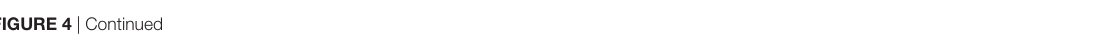
FigUre 4 | Continued Specific CD8 + T cells accumulate in the spleen and lymph node and do not migrate into the heart after anti-LFA-1 treatment. A/Sn mice were immunized with ASP-2 using the heterologous “prime-boost” vaccination regimen, infected with 150 trypomastigotes forms of Trypanosoma cruzi and treated with anti-LFA-1 or isotype control until the 20th after infection. In this day, spleen, heart, liver, lymph nodes, and blood cells of the immunized, infected, and treated or not with anti-LFA-1 were labeled with anti-CD8 and H2K K -TEWETGQI multimer. (a) Frequency of specific CD8 + T cells in the spleen, lymph node, blood, heart, and liver, respectively. (B–F) Absolute number of specific CD8 + T cells in the spleen, lymph node, blood, heart, and liver, respectively. The results for the spleen, lymph node, and liver are representative values of an individual in each group ( n = 4) with mean ± SD. While the results for the blood and heart were taken from a pool of five individuals per group, values of an individual of each repetition ( n = 2) with mean ± SD. Statistical analysis was performed using the one-way ANOVA. (g) Histograms represent MFI of specific CD8 + T cells that express CD11a onto the surface in the spleen, blood, and heart, respectively, and the group naïve the MFI of CD11a was analyzed onto the surface of CD8 + T cells. Asterisks denote statistically significant differences between of groups 2 and 3 (** P <